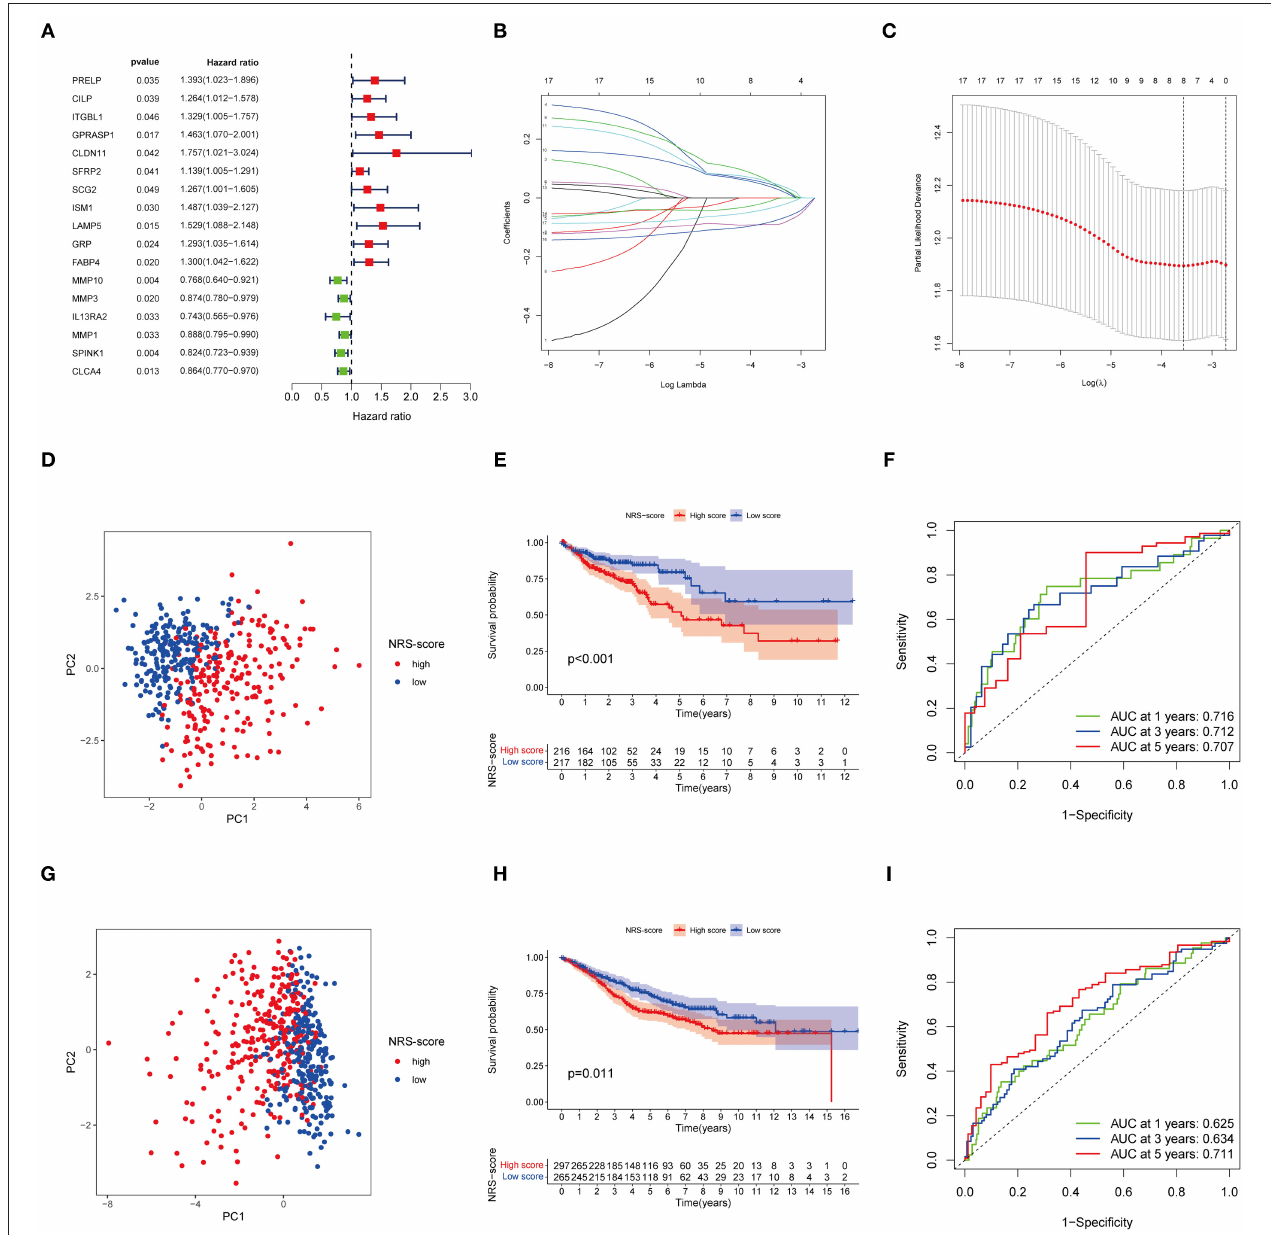
FIGURE 4 | Identification and validation of necroptosis-related prognostic signature in colon cancer. (A) Univariate Cox regression analysis showed a total of 17 prognostic-related genes. (B,C) The least absolute shrinkage and selection operator (LASSO) algorithm was used to obtain the coefficients of the genes selected to build the prognostic signature. (D) The PCA analysis showed that colon cancer patients in the TCGA cohort were significantly divided into high NRS-score and low NRS-score groups. (E) Kaplan-Meier curve of OS for patients in the high NRS-score and low NS-score groups from the TCGA cohort. (F) Time-dependent ROC curves for predicting overall survival at 1, 3, and 5 years in the TCGA cohort. (G) The PCA plot based on the NRS-score in the GSE39582 cohort. (H) Kaplan-Meier curve for the high NRS-score and low NRS-score subgroups in the GSE39582 cohort. (I) ROC curves for predicting 1-, 3-, and 5-year OS in the GSE39582